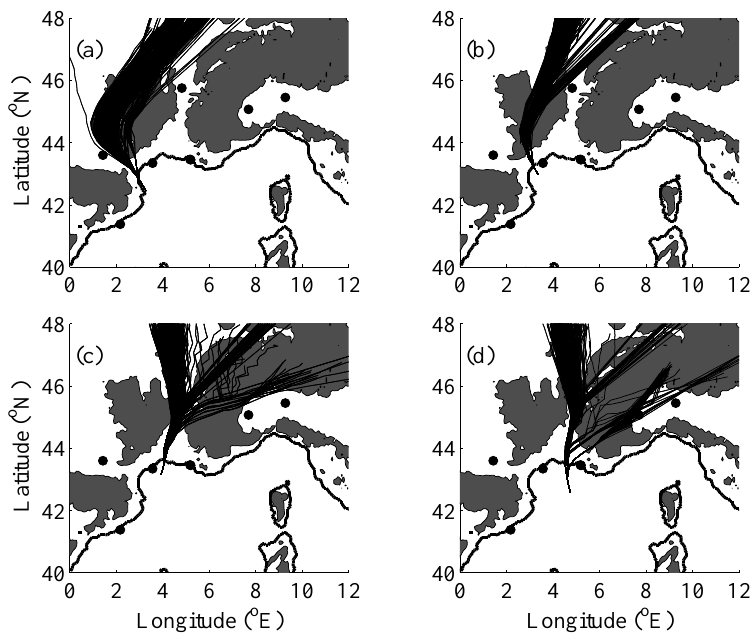
Fig. 12. Back plumes ending at 3.3 ◦ E/42.5 ◦ N (a) , 3.39 ◦ E/43 ◦ N (b) , 3.95 ◦ E/43.16 ◦ N (c) and 4.75 ◦ E/42.6 ◦ N (d) (shown in Fig. 8). The altitude of the ending points is 50m. The ending time of the back plumes is 11:00UTC which is the time of the passage of SeaWIFS over the western Mediterranean. The wind fields used to compute these back plumes are from the 9-km mesh size domain. Filled black dots indicate the cities of Barcelona, Toulouse, Montpellier, Marseille/Fos-Berre, Lyon, Torino and Milano.